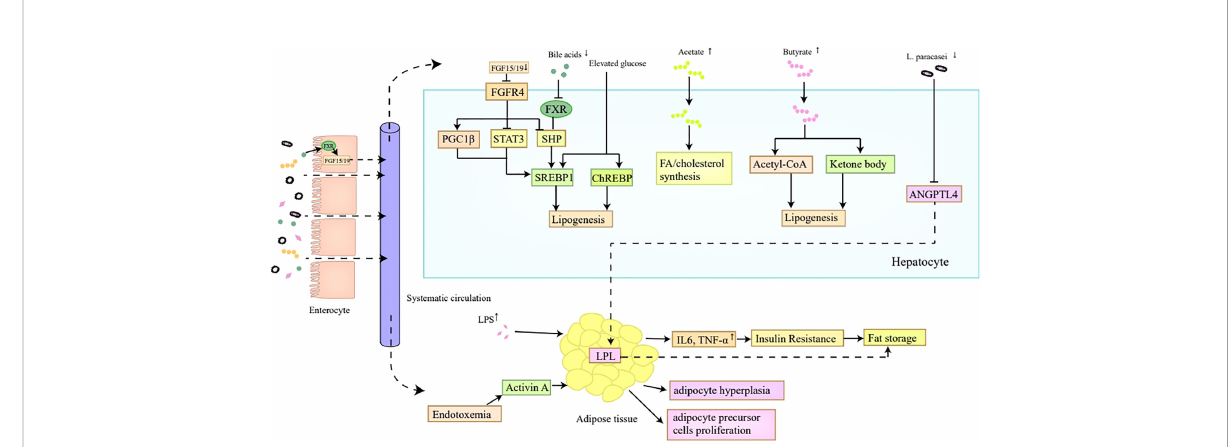
FIGURE 2 Lipid synthesis and storage. The reduction of bile acids in obesity inhibits FXR in hepatocytes, which ultimately induces the transactivation of SREBP1c mediated by SHP, thus contributing to hepatic de novo lipogenesis. Decreased bile acids are also unfavorable for FGF15/FGF19 secretion in the intestine, which then inactivates FGFR4 on hepatocytes and promotes SREBP1c transactivation indirectly by inhibiting SHP, and directly by inducing PGC1 b and repressing STAT3, ultimately enhancing hepatic lipogenesis. Moreover, the SREBP1 and ChREBP expression can also be promoted by elevated glucose level which correlates with higher Glut2 expression induced by altered gut microbiota in obesity. In addition, the increased SCFAs in obesity, especially acetates and butyrates, can act as precursors for FA or cholesterol synthesis. The reduced L. paracasei in obese individuals putatively contributes to lipid storage by releasing the inhibition of LPL induced by ANGPTL4. Furthermore, elevated levels of proin fl ammatory cytokines and metabolic endotoxemia induced by LPS correlate with insulin resistance and the proliferation of adipocytes and adipocyte precursor cells, which all make contributions to lipid storage. FXR, Farnesoid X Receptor; SREBP1c, sterol regulatory binding protein1c; SHP, small heterodimer partner; FGF, fi broblast growth factor; PGC1 b , peroxisome proliferator-activated receptor- g coactivator 1 b ; STAT3, signal transducer and activator of transcription; ChREBP, carbohydrate response element binding protein; SCFAs, short- chain fatty acids; FA, fatty acids; LPL, lipoprotein lipase; LPS,